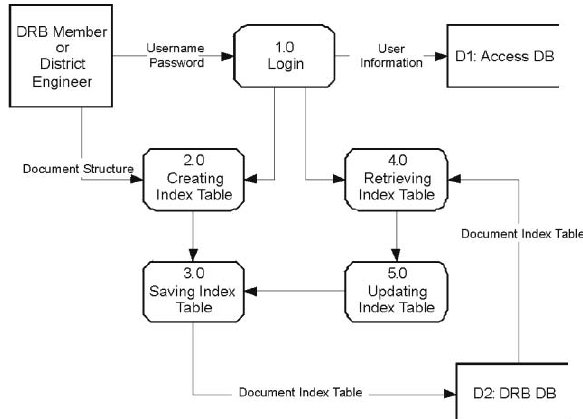
Fig. 2. Process Model for a Document Index Table